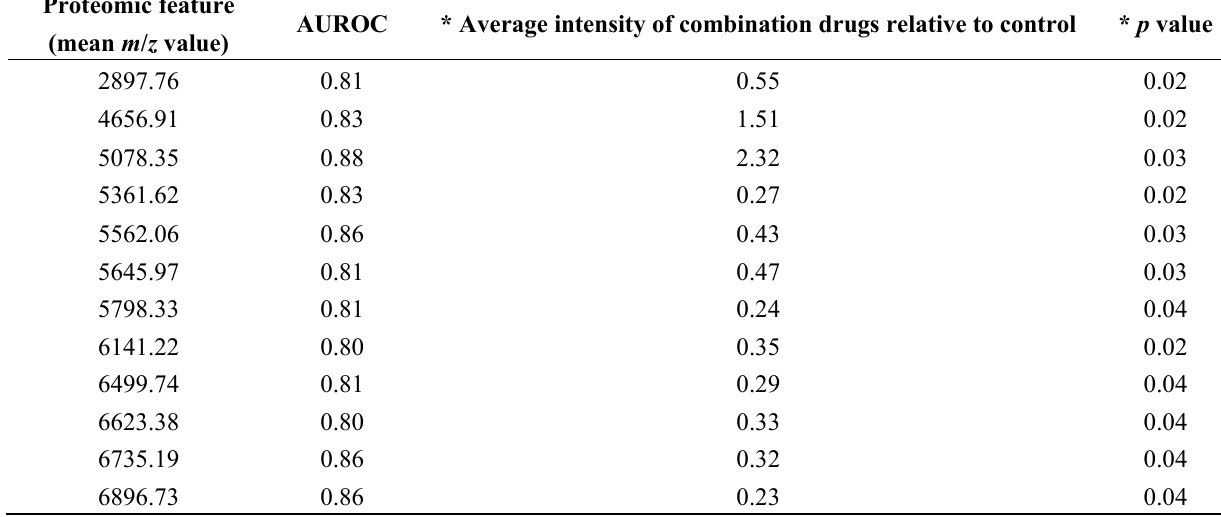
Table 1. Discriminatory proteomic features between control and treated cells.